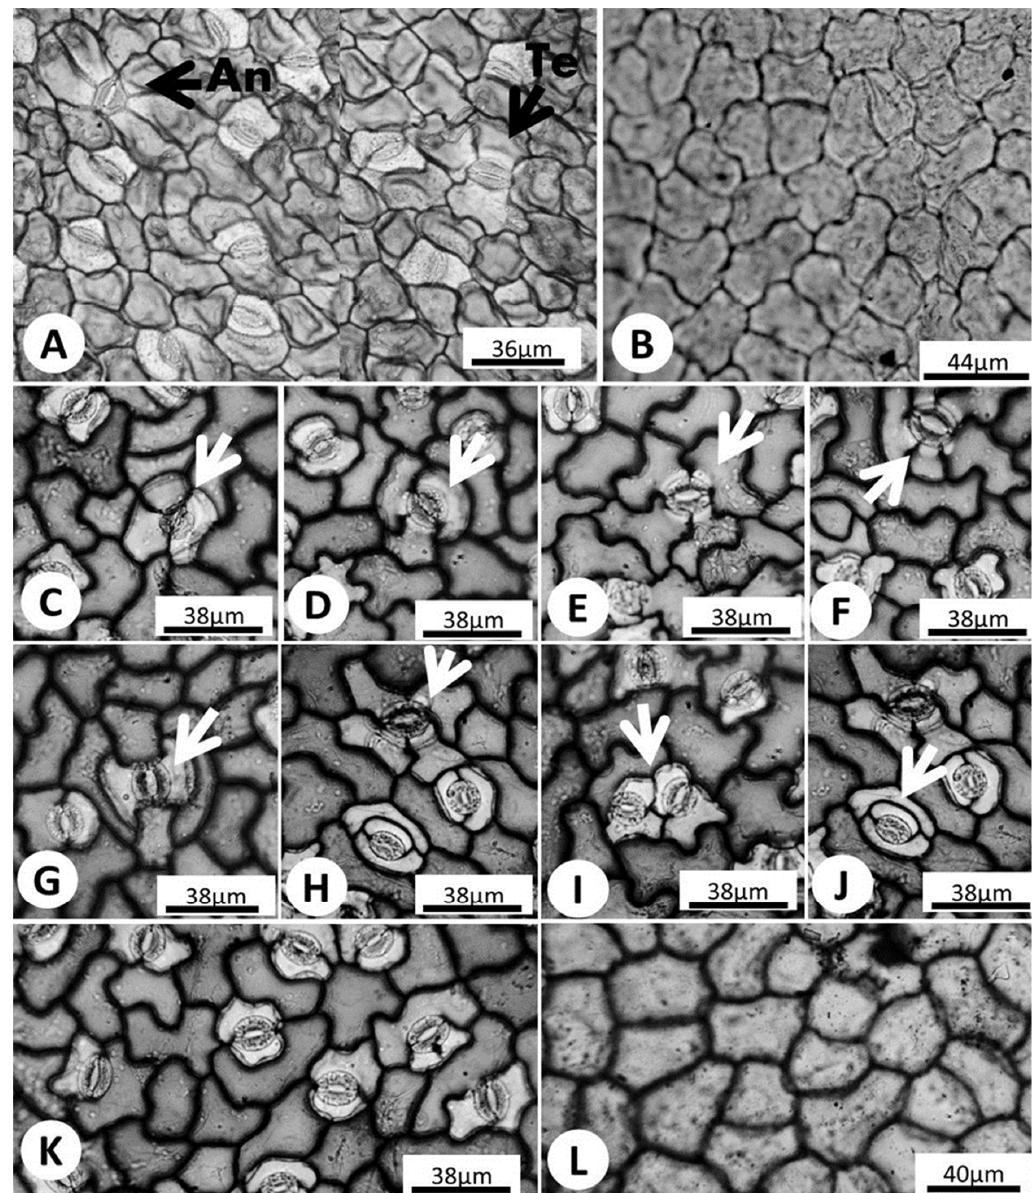
Figure 3. Epidermal and stomatal types in Adenia species studied; (A) Abaxial surface of A. cissampeloides, (B) Adaxial surface of A. cissampeloides , (C – K) Abaxial surface of A. lobata and (L) Adaxial surface of A. lobata An = anomocytic stoma; Te = tetracytic stoma